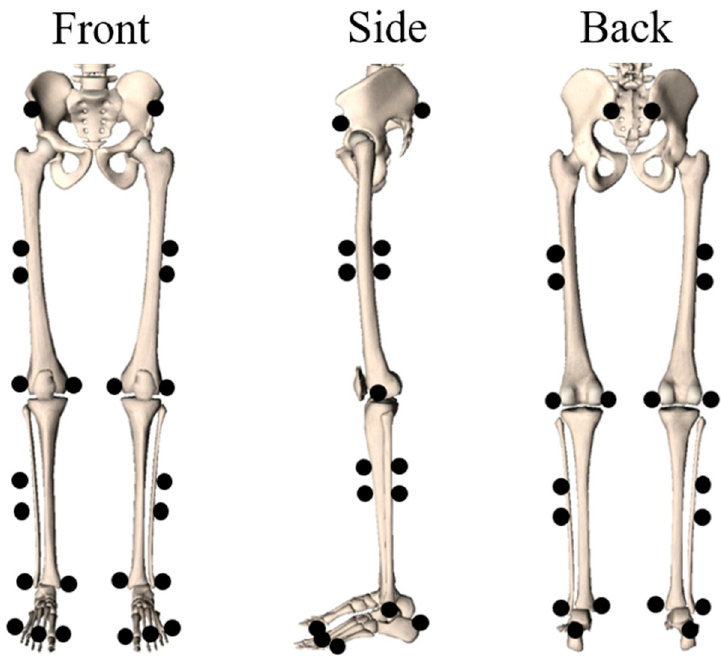
Figure 1. Illustration of lower limb and pelvis reflective markers placement.